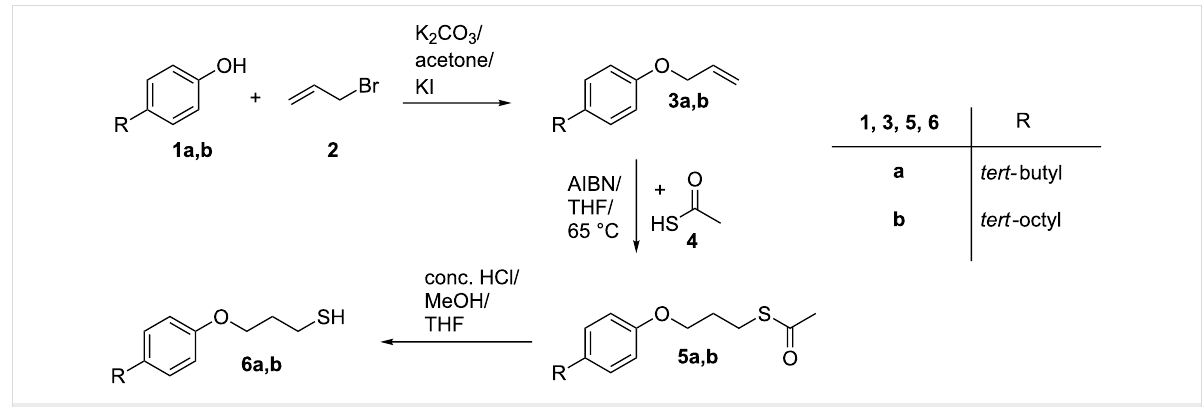
Scheme 1: Synthetic route for the synthesis of thiol functionalized